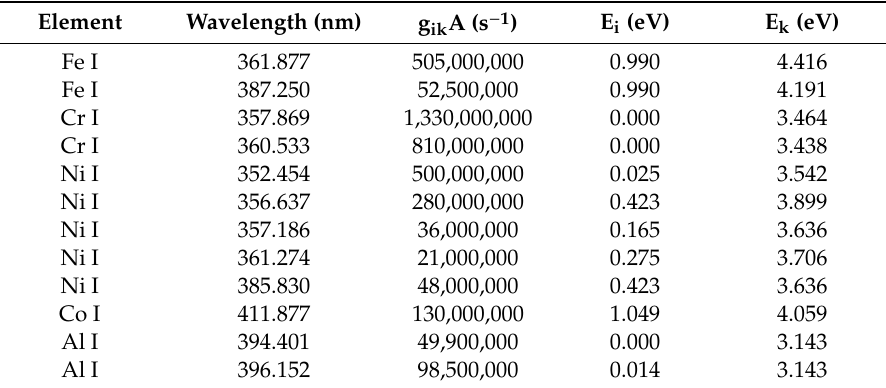
Table 5. Parameters of spectral lines for the lines of component calibration.